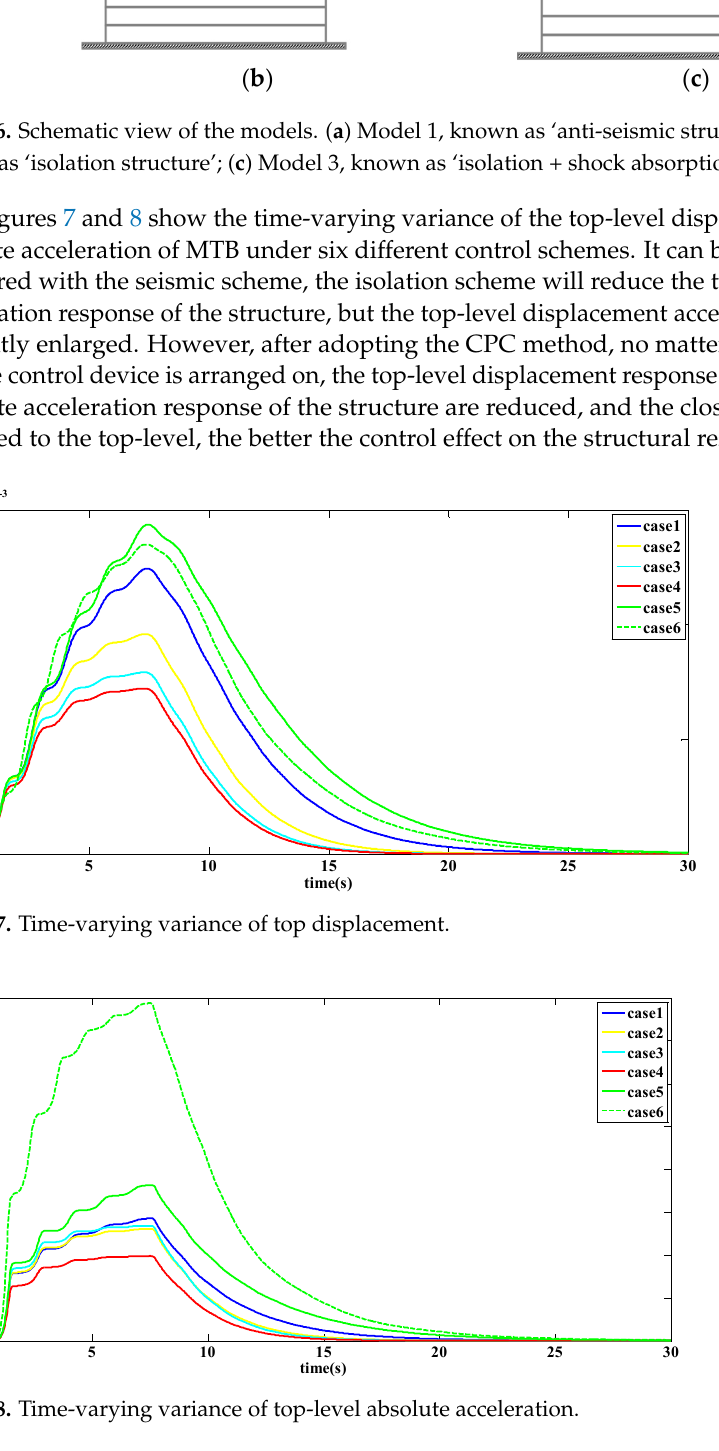
Figure 8. Time-varying variance of top-level absolute acceleration .